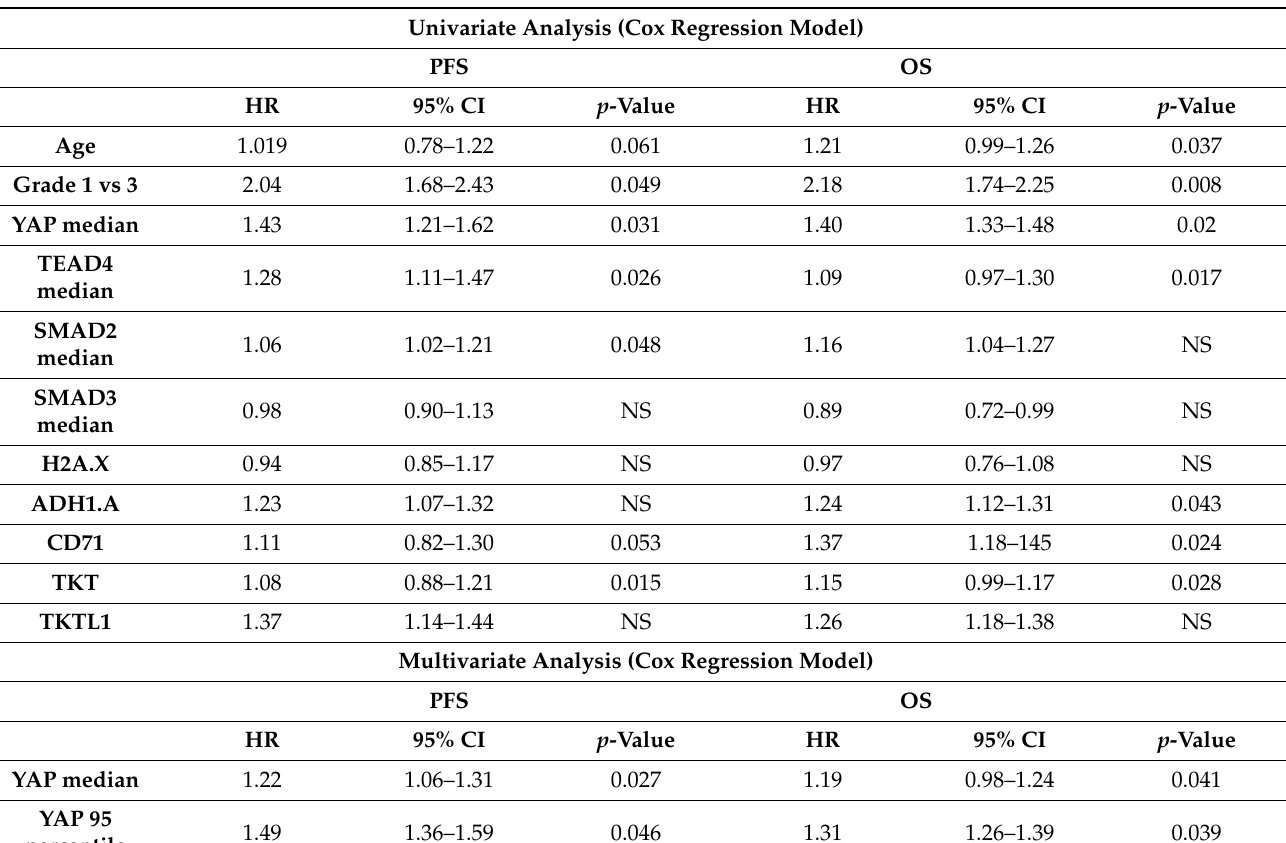
Table 7. Univariant and multi variant analyses (Cox regression model). Univariate Analysis (Cox Regression